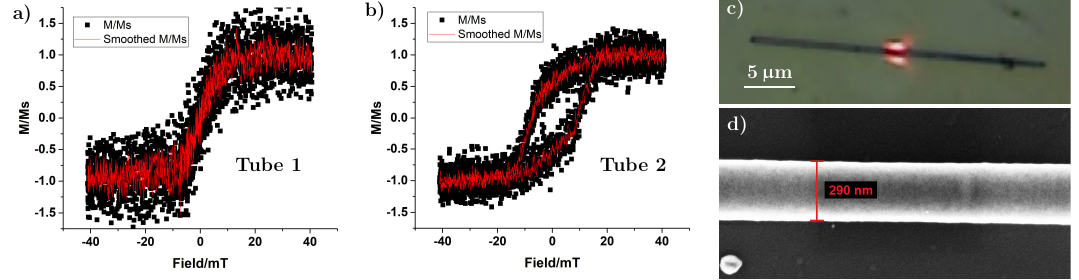
Fig. 9: Magnetometry on a single tube – magnetooptics with focused laser. Hys- teresis loops for the axial magnetic field: a) slanted curve, b) rather squared loop obtained on another tube. Average of 100 loops with short acquisition time (0.9 s). Data processed in OriginPro: line subtracted, normalized, smoothed: average of 7 adjacent points (red curve) - original curve 5000 points (black points). c) Optical im- age (magnification 100x) of a tube with the diffracted laser spot, the magnetic field is applied in the horizontal direction, close to parallel to the tube axis. d) Scanning electron microscopy image of a central part of the tube from